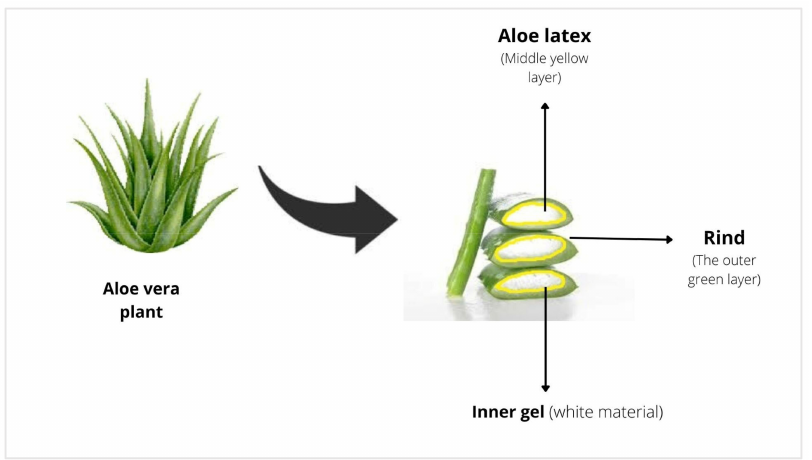
Figure 1. Gross morphology of the Aloe vera plant. Polysaccharides, phenolic substances, vitamins, minerals, sugars, proteins, and saponins make up its gel and have unique pharmacological properties in various disorders [47,48].